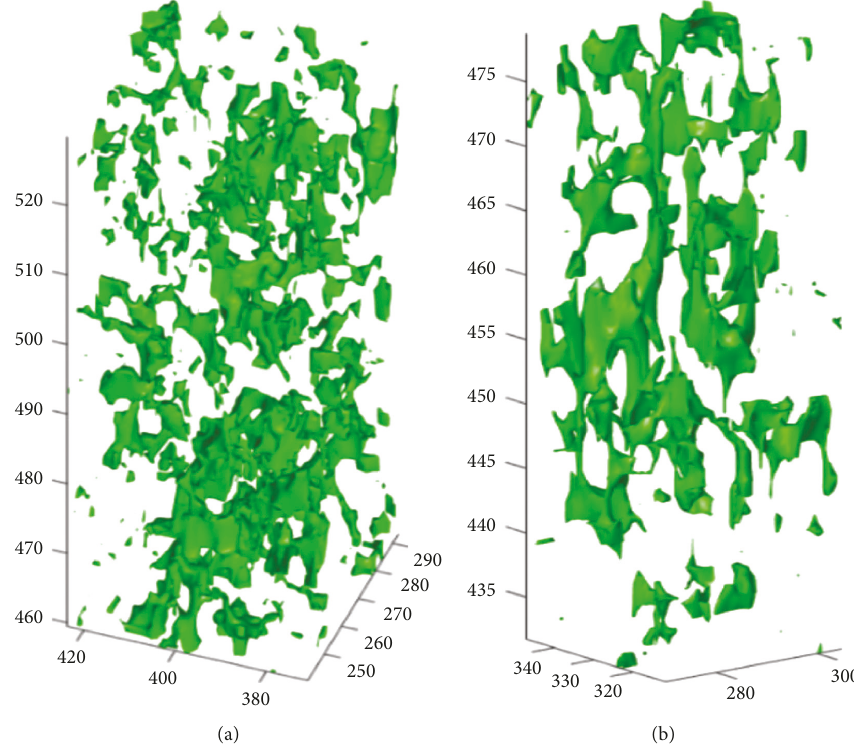
Figure 4: Pore distribution and channel development affected by raking.